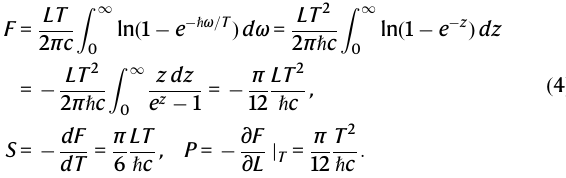
Fig. 3 as a solid curve, fi ts the experimental data points very well. Note that there is no fi tting parameter in Eq. (3), once the critical coverage − 2 is determined from the phase diagram (Fig. ρ cr =1.4nm